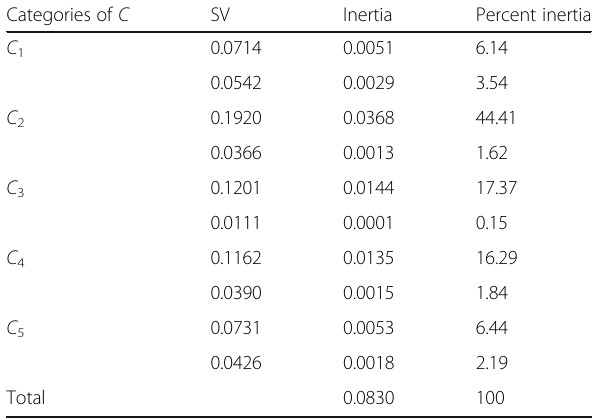
Table 8 Results of subset MCA for Table 6 along B and A across C